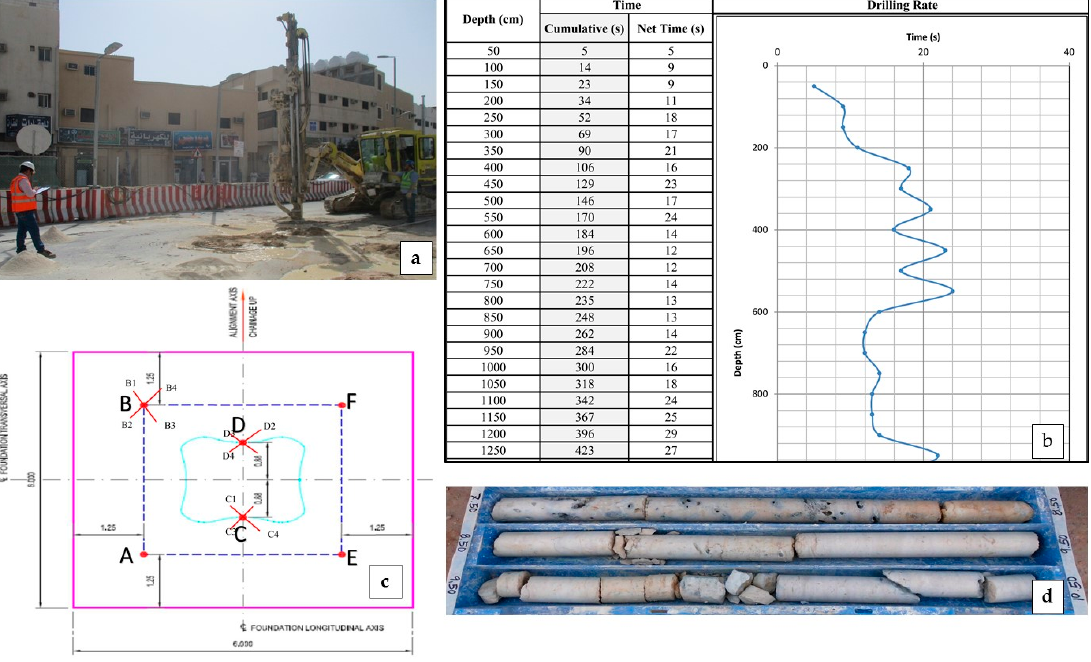
Figure 3. Probehole drilling and grouting on the footprint of a shallow foundation: ( a ) hydraulic rig using the rotary-percussion method; ( b ) probehole record with karst detection from 5.6 to 9.4 m